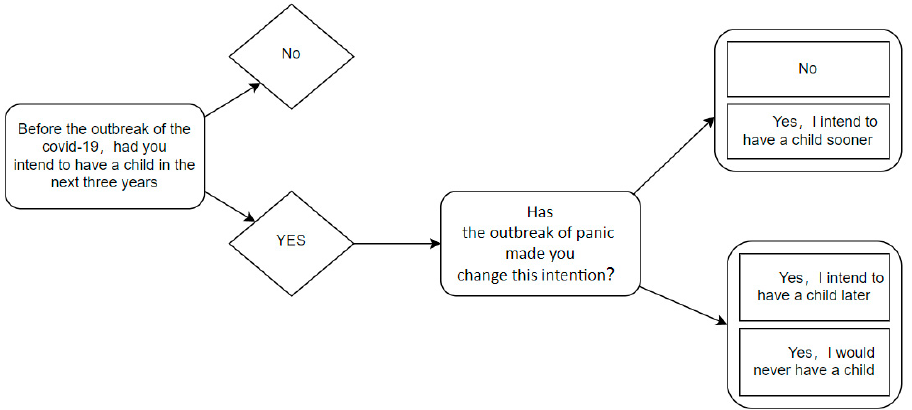
Figure 1. Variable interpretation plot.